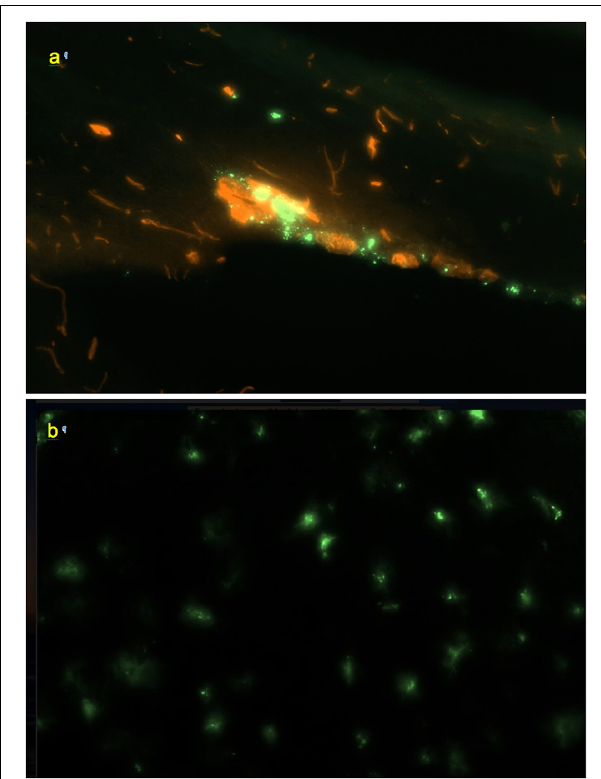
FIGURE 6 | Labeling of perivascular channels with Alexa-350-rhNAGLU in monkey ( M. mulatta ). (a) Perivascular cells around arteries branching from the arcuate sulcus (AS) and entering cortex from its surface (CS), 4.4 mm × 2.9 mm. (b) Perivascular channels branching from the anterior subcentral sulcus (SAS), 3 mm × 2 mm. 100 µ m cryosections. High resolution versions: Supplemental Figures S15–S17